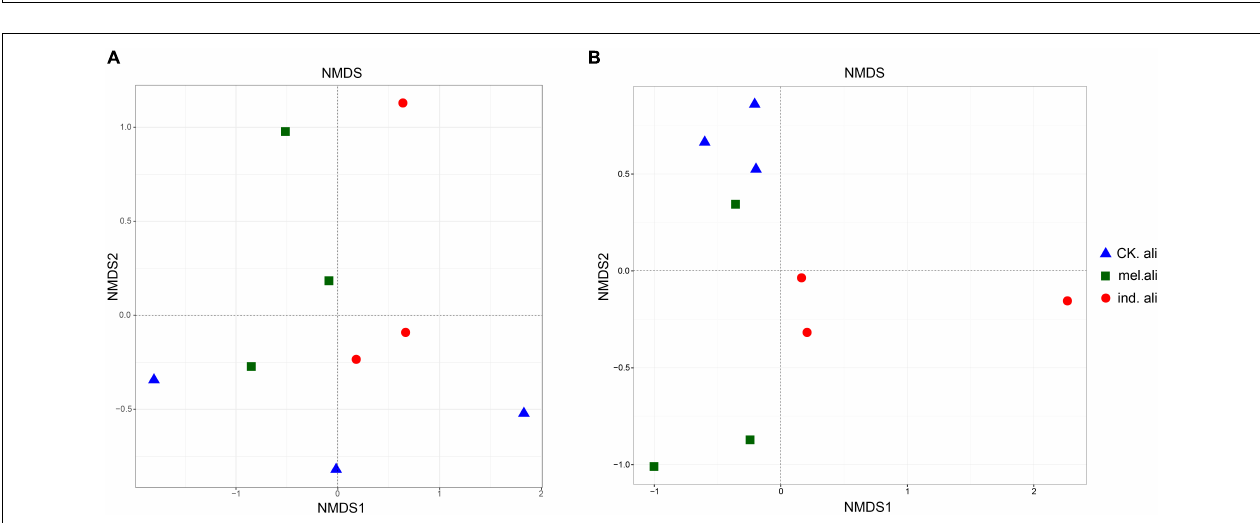
FIGURE 4 | Heat-maps of the most abundant (A) nirK - and (B) nirS -type denitrifying bacterial genera in rhizosphere soil of Quercus aliena . CK.ali, uninoculated Q. aliena ; ind.ali, Q. aliena inoculated with Tuber indicum ; and mel.ali, Q. aliena inoculated with Tuber melanosporum .